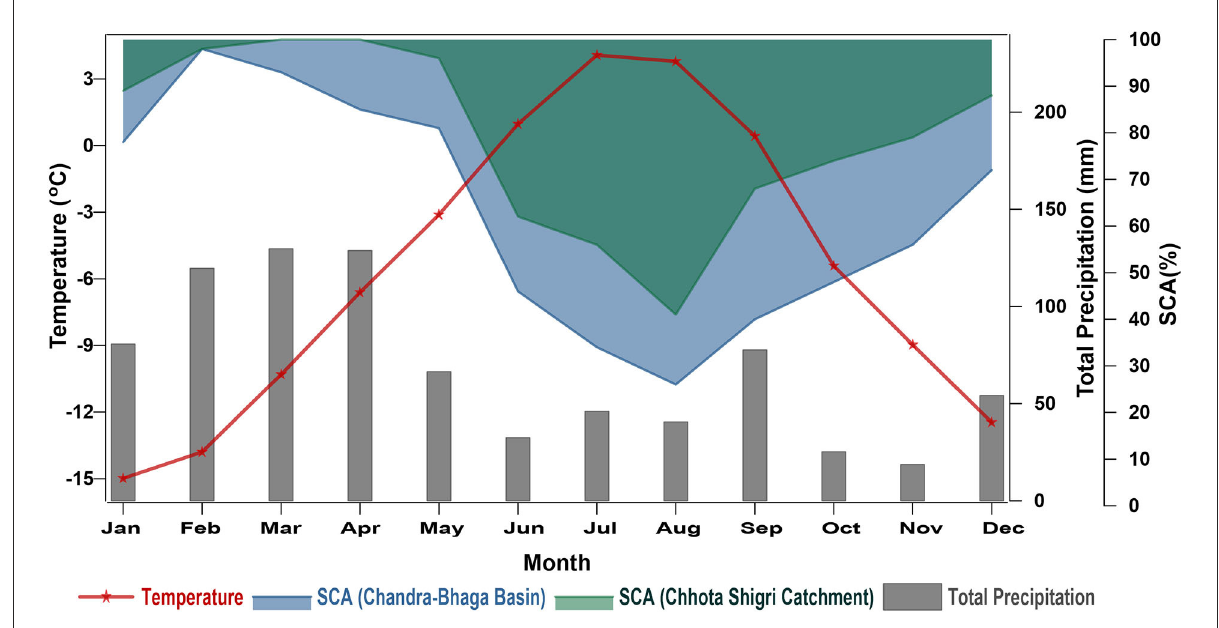
FIGURE3 Monthly variation of model variables ERA5 bias-corrected (temperature and precipitation) and SCA for Chhota Shigri Catchment and Chandra-Bhaga Basin over 2003–2018.